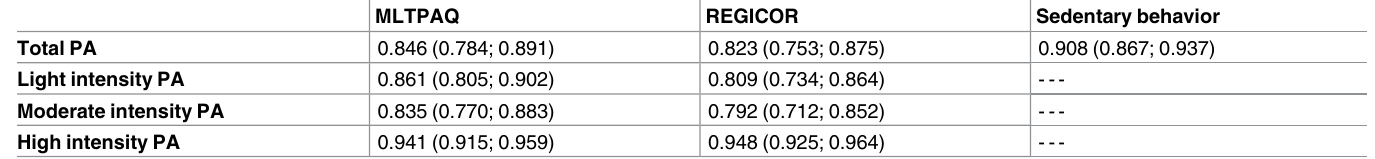
Table 4. Reliability of the questionnaires administered in a one-week interval, assessedby the intraclass correlation coefficient.